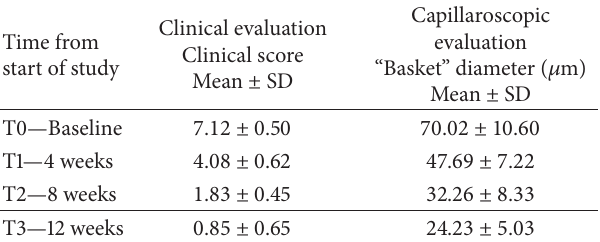
Table 1: Diameters of the “baskets” and clinical score following treatment with